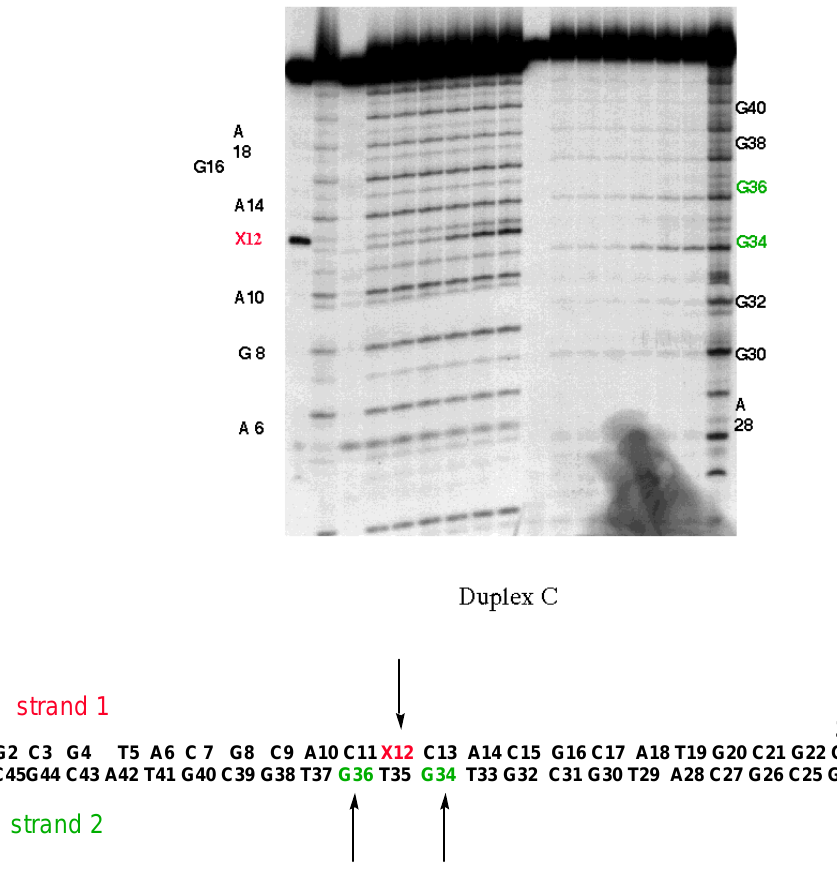
Figure 13. Recognition of abasic sites in DNA by cyclobisacridine 1 : Photocleavage experiments. One sample was treated by exonuclease III to localize on the gel the position of the abasic site